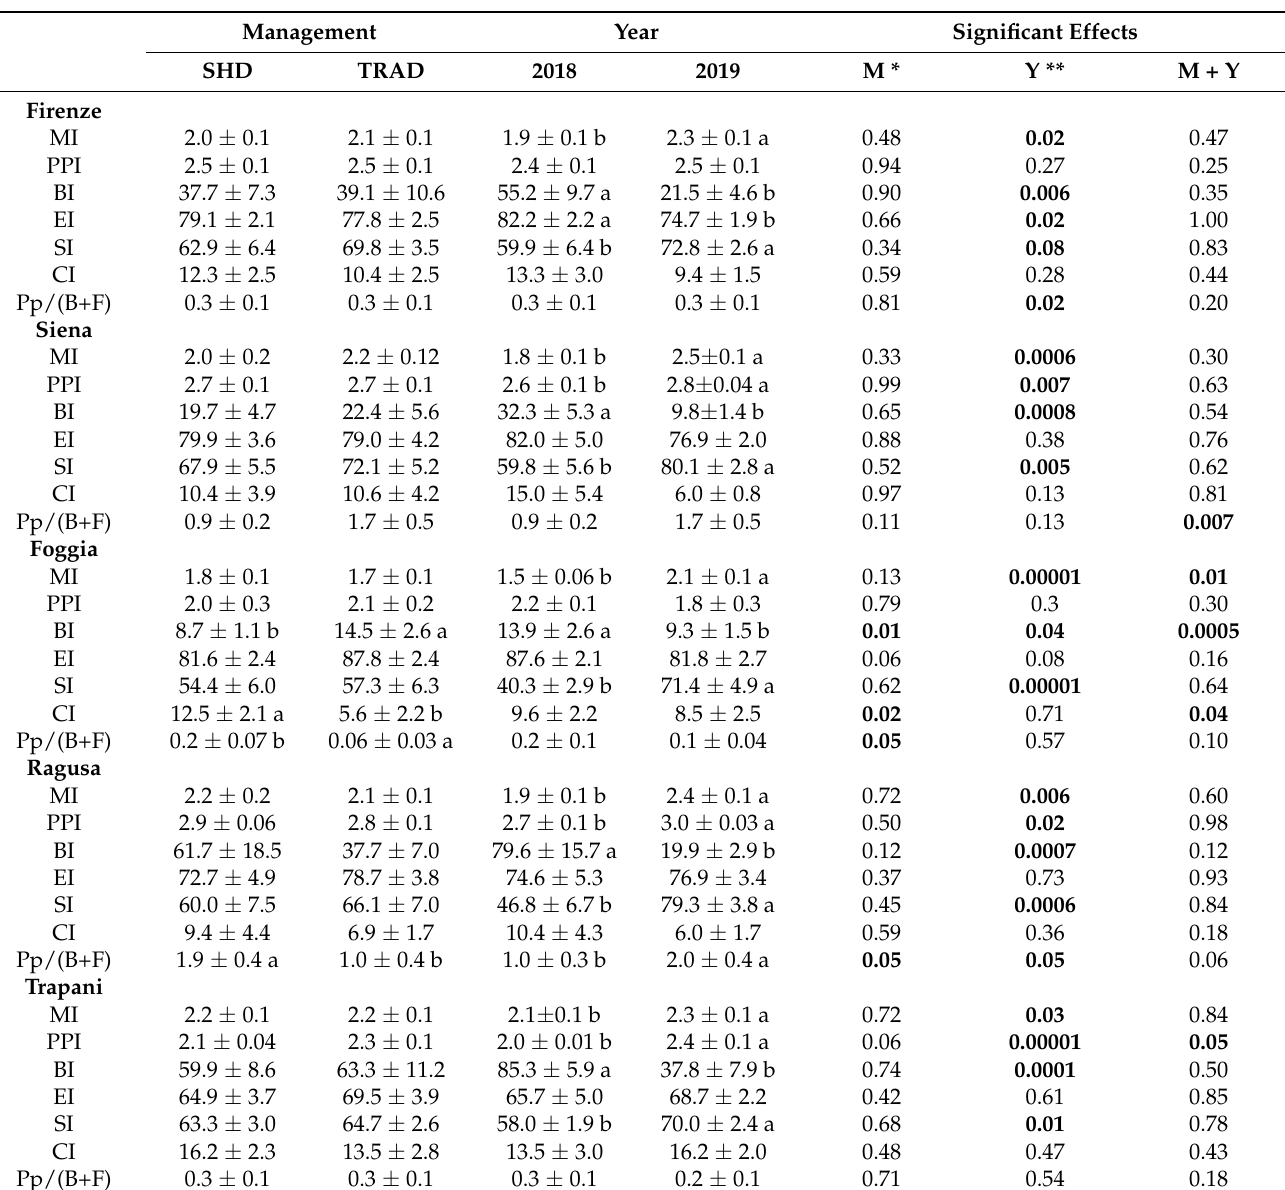
Table 2. Effect of different management methods on soil nematode indices. SHD, super-high density olive orchards; TRAD, traditional olive orchards; MI, maturity index; PPI, plant-parasitic index; BI, basal index; EI, enrichment index; SI, structure index; CI, channel index; Pp/B+F, the ratio of obligate plant parasites to bacterivores and fungivores. Different letters indicate significant differences at p < 0.05. Standard errors are reported. Significant differences are highlighted in